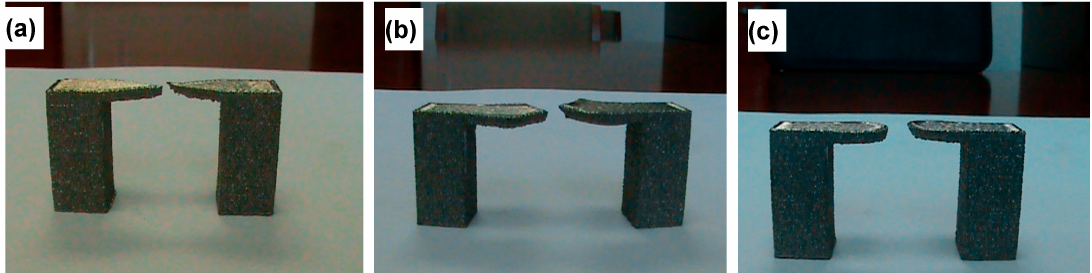
Figure 13. Overhang distortion comparison between with heat support (Left) and without support (Right) for different overhang shapes: ( a ) Triangle, ( b ) pentagon, ( c ) and circle.